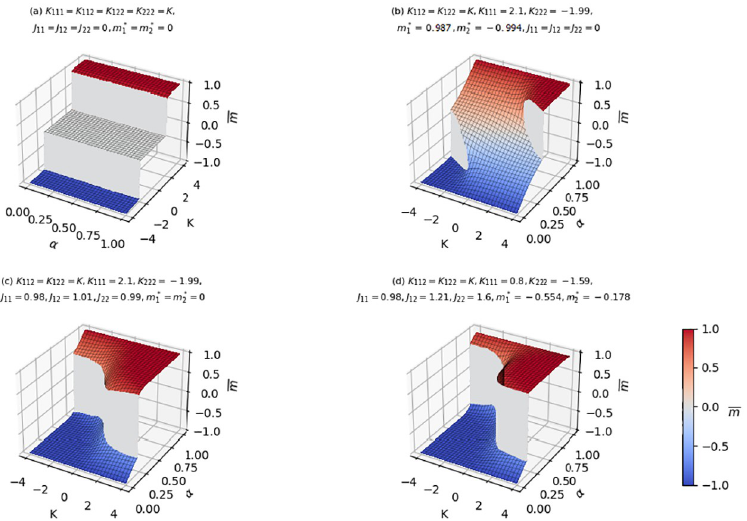
Fig 3. Total average opinion surfaces of the two component cubic mean-field model. In panel (a) we observe first order phase transitions at K c . Here, α is constant in K . When the cubic interactions are fixed (i.e. K 111 = K 112 = K 122 = K 222 = K ) the proportion of AI and Human agents present in the system has no effect on their average opinion as observed in panel (a) . Two distinct jumps in � m are observed in panel (b) for certain values of K and α . For panel (c) and (d) α varies smoothly for the total average opinion and then observe sudden jump to another